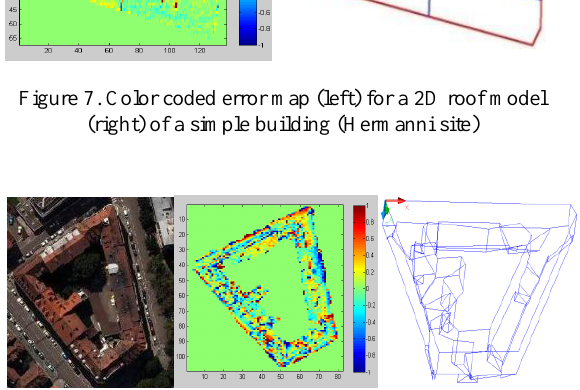
Figure 8. Automatic building modeling of a complex building (Strasbourg site). From left to right: aerial image, error map, complete (distorted) 3D building model.